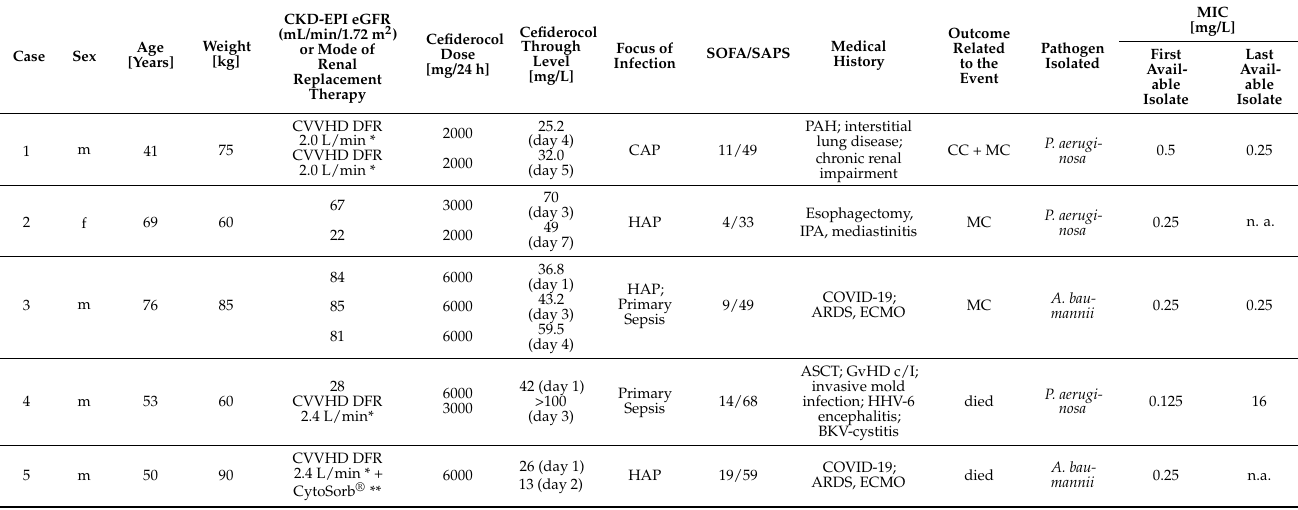
Table 1. Demographic data, extracorporeal therapies and microbiological